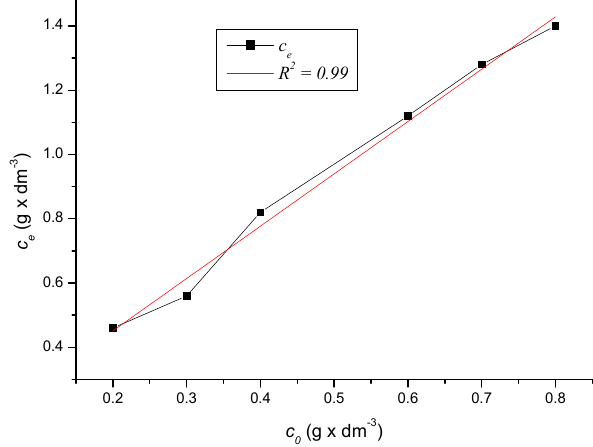
Figure 10. Dependence of equilibrium concentration on initial concentration in 120 min.